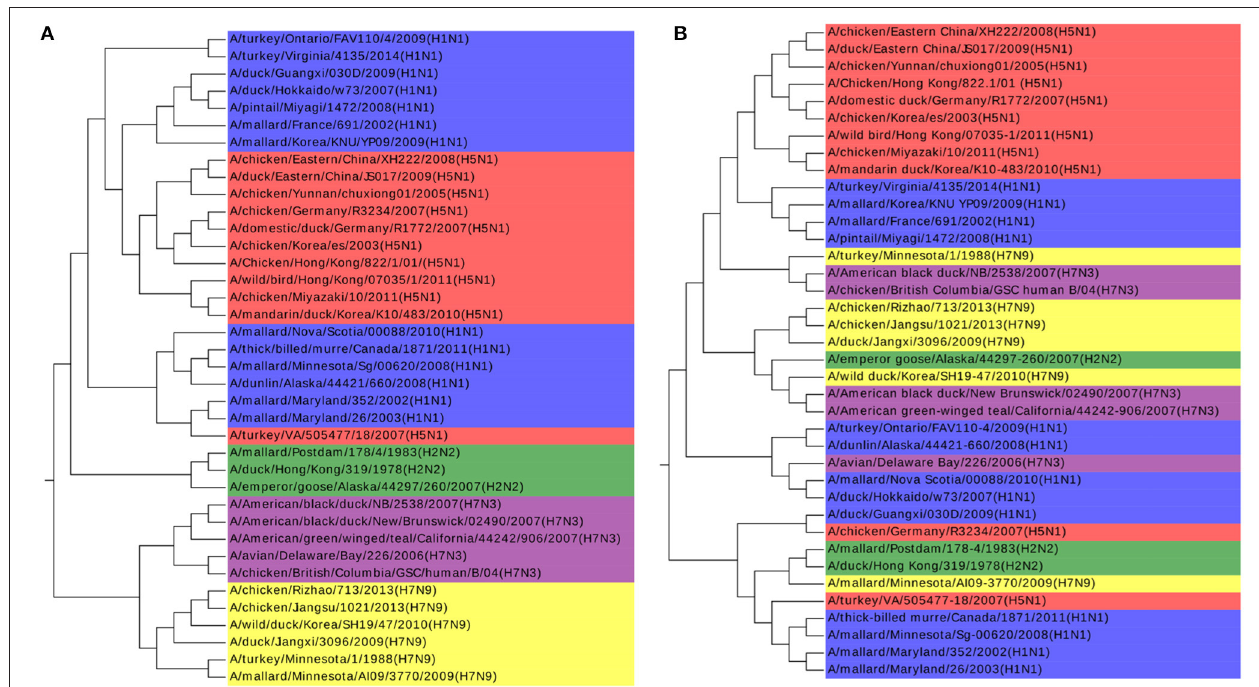
FIGURE 5 | The Natural Graph using ANV method on Influenza A virus dataset.